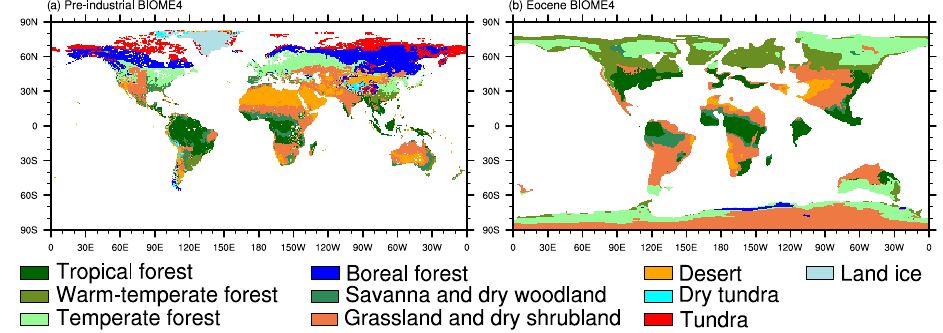
Figure 6. (a) Pre-industrial and (b) Eocene vegetation simulated by BIOME4. The 27 biomes simulated by BIOME4 have been consolidated into 10 mega biomes following Harrison and Prentice